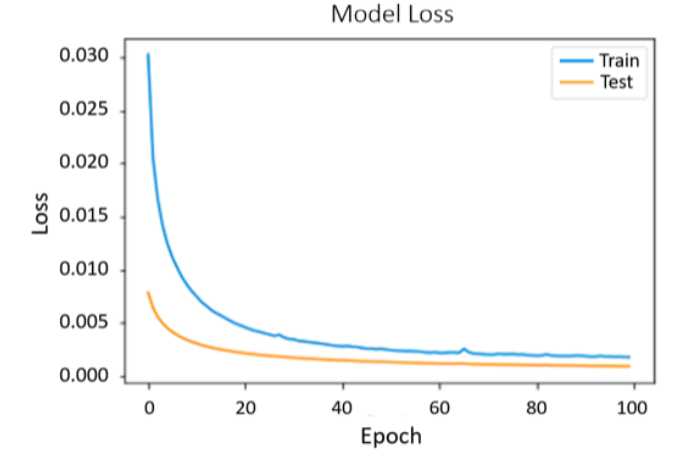
Figure 8. Model loss autoencoder